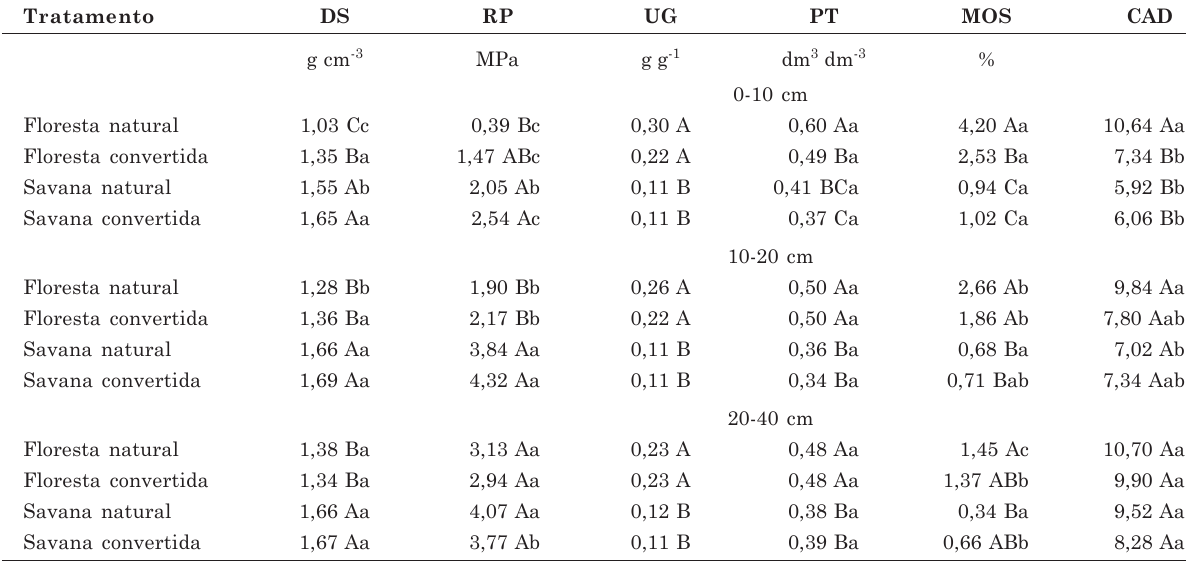
Quadro 3. Valores médios de densidade do solo (DS), resistência à penetração (RP), umidade